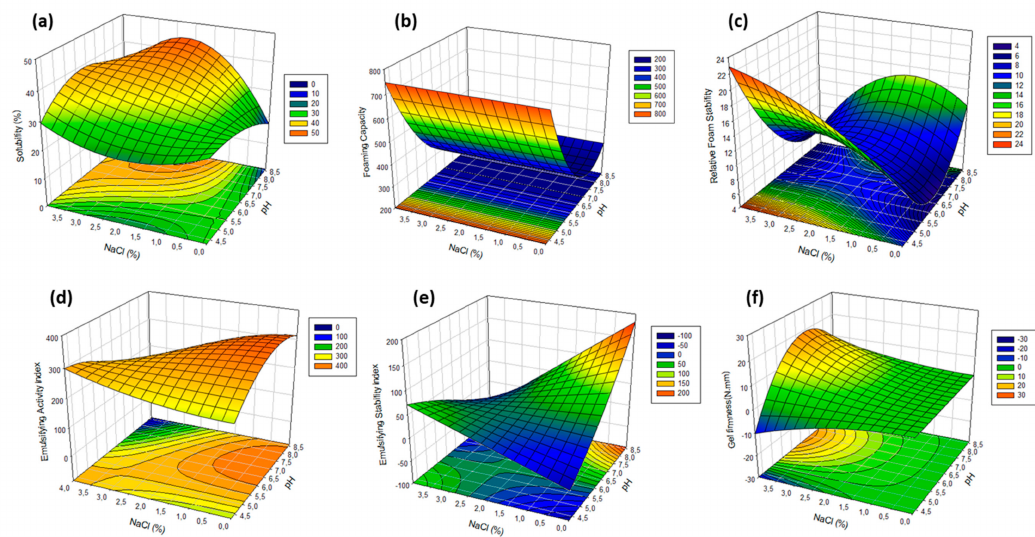
Figure 3. Response surface graphs and contour plot of the protein extracts from porcine heart as a function of pH and salt concentration of the extraction bu ff er. ( a ) Protein solubility (%) and surface properties (5 g L − 1 protein); ( b ) foaming capacity (mL); ( c ) relative foam stability (min); ( d ) emulsifying activity index (m 2 g − 1 ); ( e ) emulsion stability index (min); and ( f ) gel firmness after heating (80 ◦ C for 40 min) (N